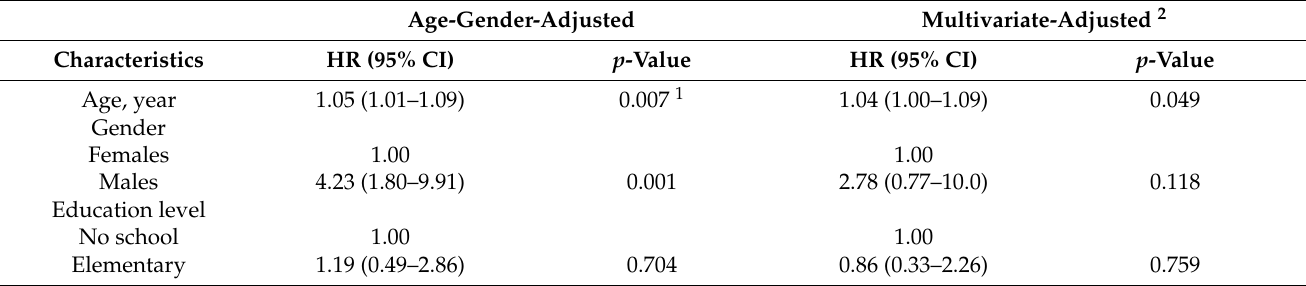
Table 2. Adjusted hazard ratio (HR) of baseline characteristics in relation to liver cancer among the study